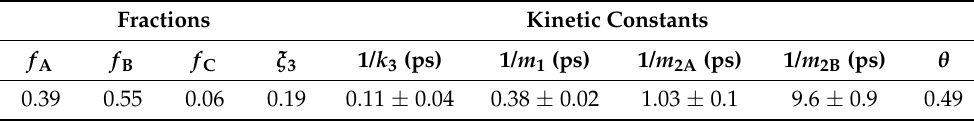
Table 2. Kinetic model of the B 1 bleach peak and the Stark shift C 1 changes of the QD-2